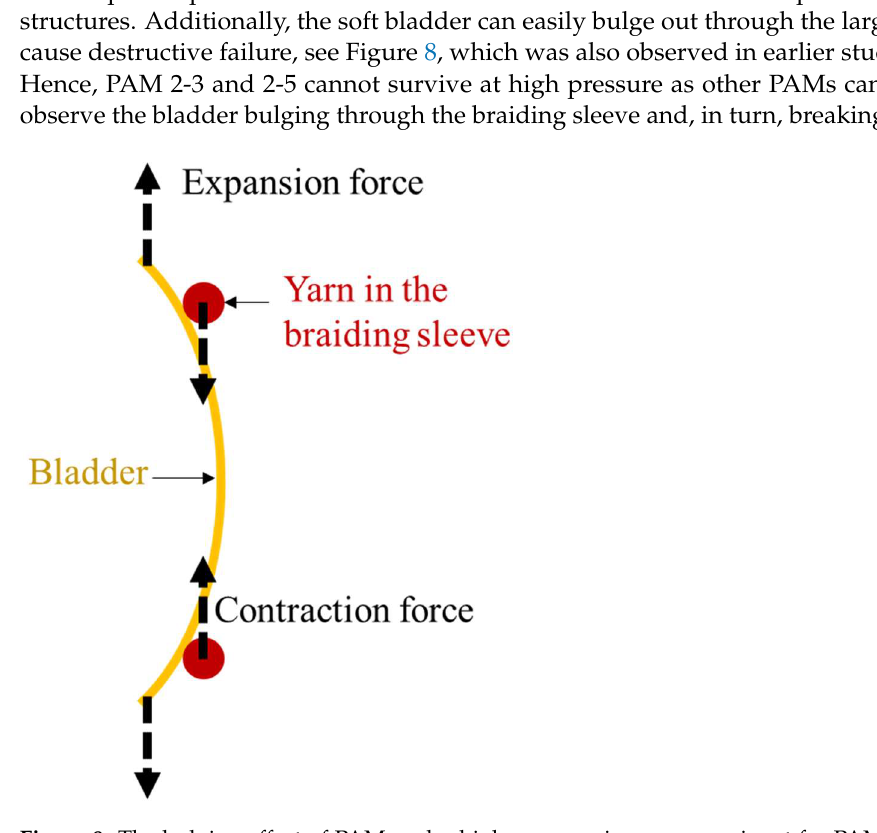
Figure 8. The bulging effect of PAM under high pressure is more prominent for PAMs fabricated with a softer bladder.